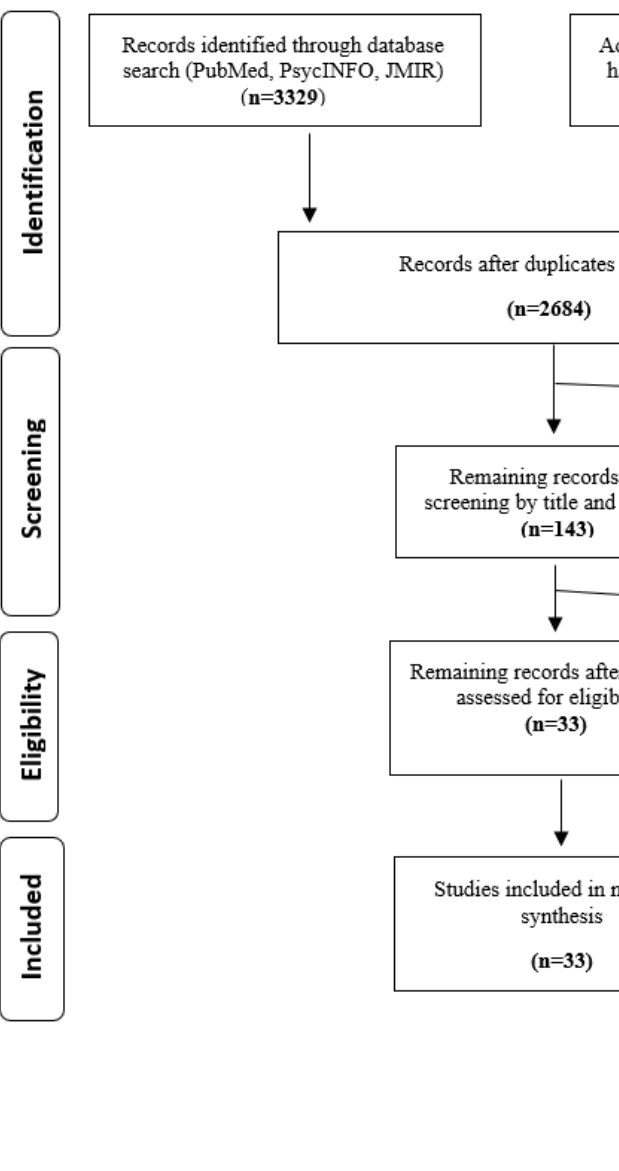
Figure 1. Flowchart of the systematic review search process. Adapted from Moher et al